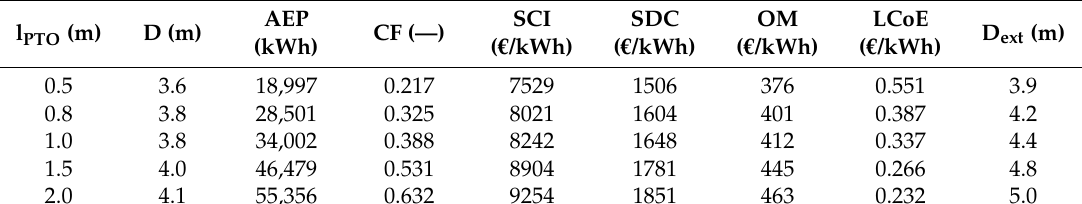
Table 9. Incidence of PTO free stroke length on main data of WEC devices with the fully submerged mass at Alghero.